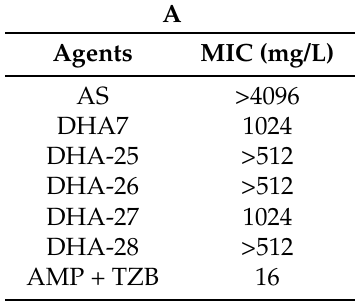
Figure 3. Structure of four representative compounds chosen to be synthesized and named as DHA25–DHA28. Table 1. Effect of AS, DHA7, and DHA25-DHA28 alone and in combination with AMP against E. coli ATCC 35218.